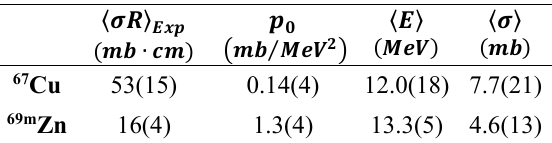
Table 2: The energy loss weighted average cross section and obtained from experimental results, and the the parameter respective average energy and cross section for 67 Cu and 𝑝𝑝 0 69m Zn.